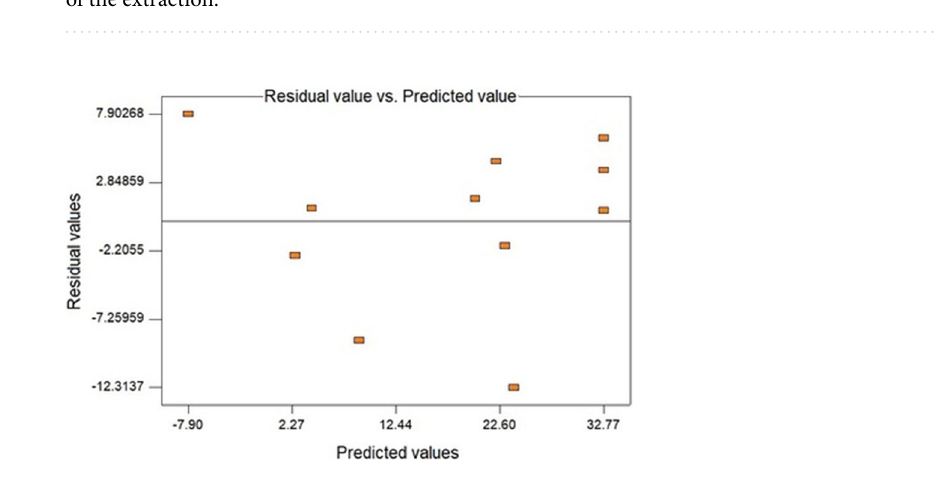
Table 4. ANOVA for the statistical treatment of the results related to the planning to obtain the optimization of the extraction.